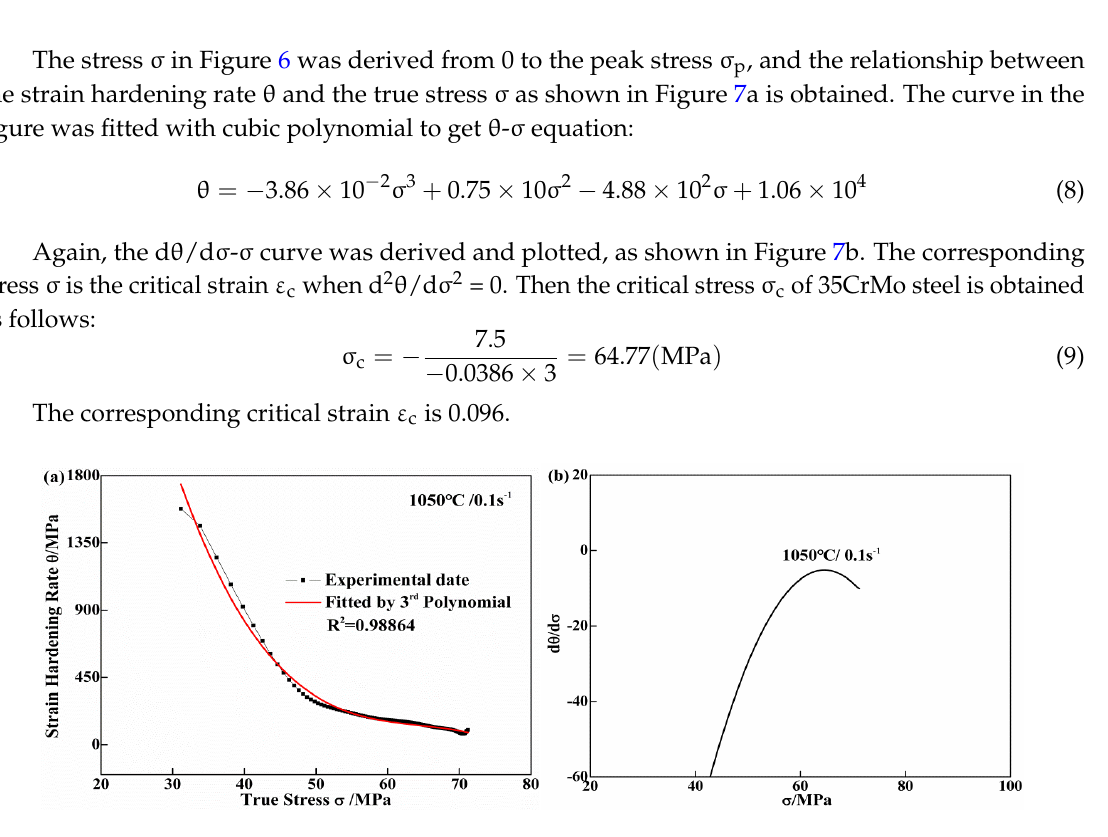
Figure 7. Curves of θ versus σ ( a ) and dθ/dσ versus σ ( b ) deformed at 1050 °C with 0.1 s −1 .